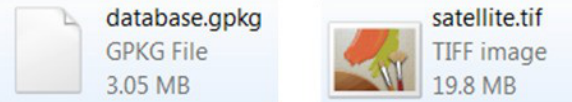
Figure 7. Comparison of two data format in file size. Left: GeoPackage data format containing vectors and raster data. Right: GeoTiff data format (satellite image).